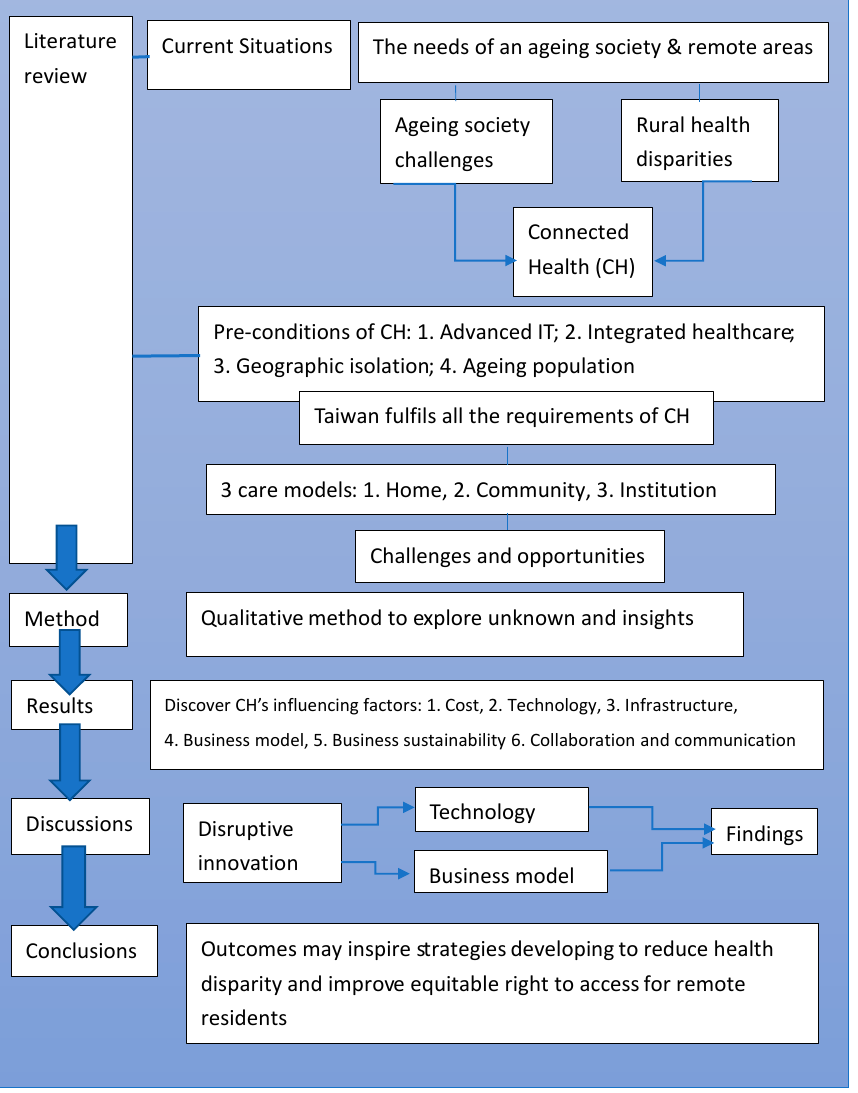
Figure 3. A conceptual framework of this study.